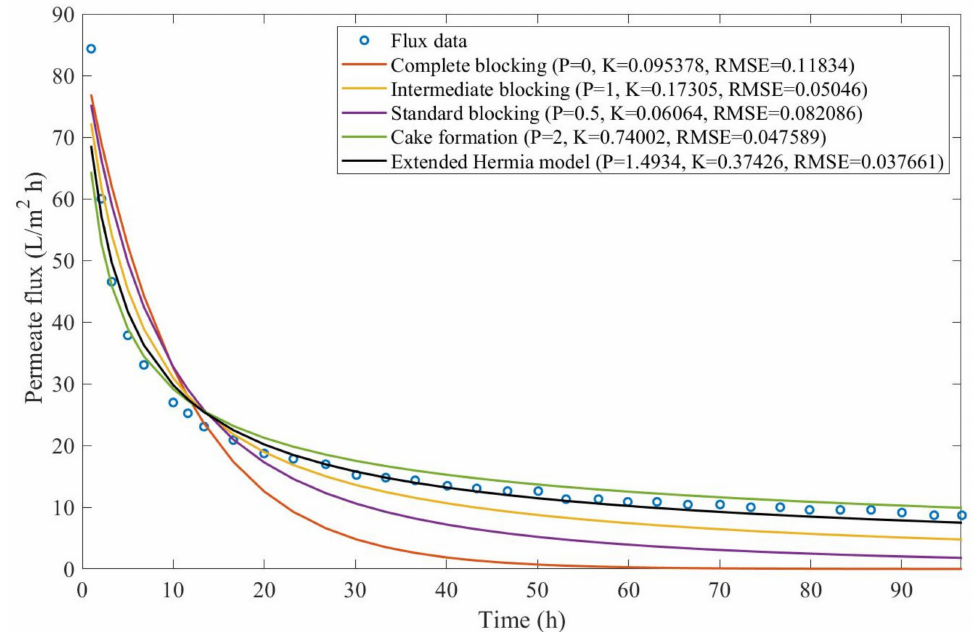
Figure A16. Model fitting for oily effluent ultrafiltration with CFR of 14 L/min and 35 kPa considering the four original pore-blocking mechanisms and the extended Hermia model (17).